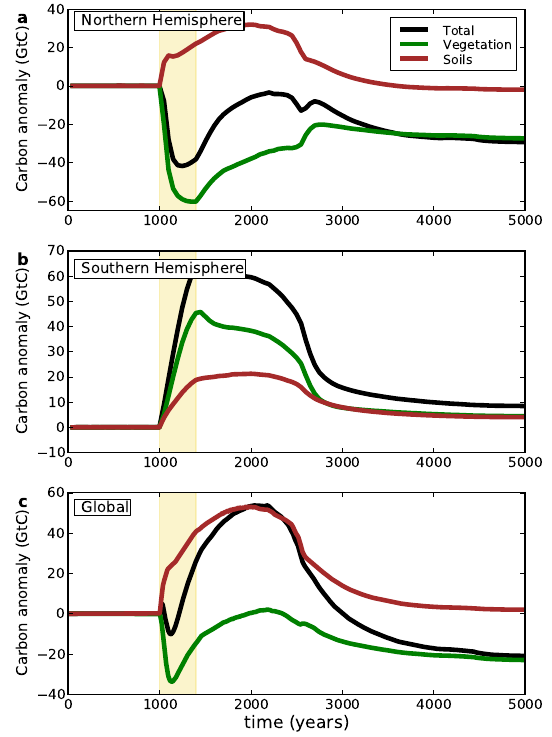
Fig. 8. Evolution of the carbon content anomaly in the terrestrial biosphere (GtC) (a) in the Northern Hemisphere, (b) in the South- ern Hemisphere and (c) total of the two hemispheres. The total carbon in the terrestrial biosphere (black) is decomposed in its two subreservoirs: the vegetation (green) and soils (brown). In the sim- ulation the fresh water flux, which is added into the North Atlantic, has an amplitude of 0.5Sv during 400 yr.